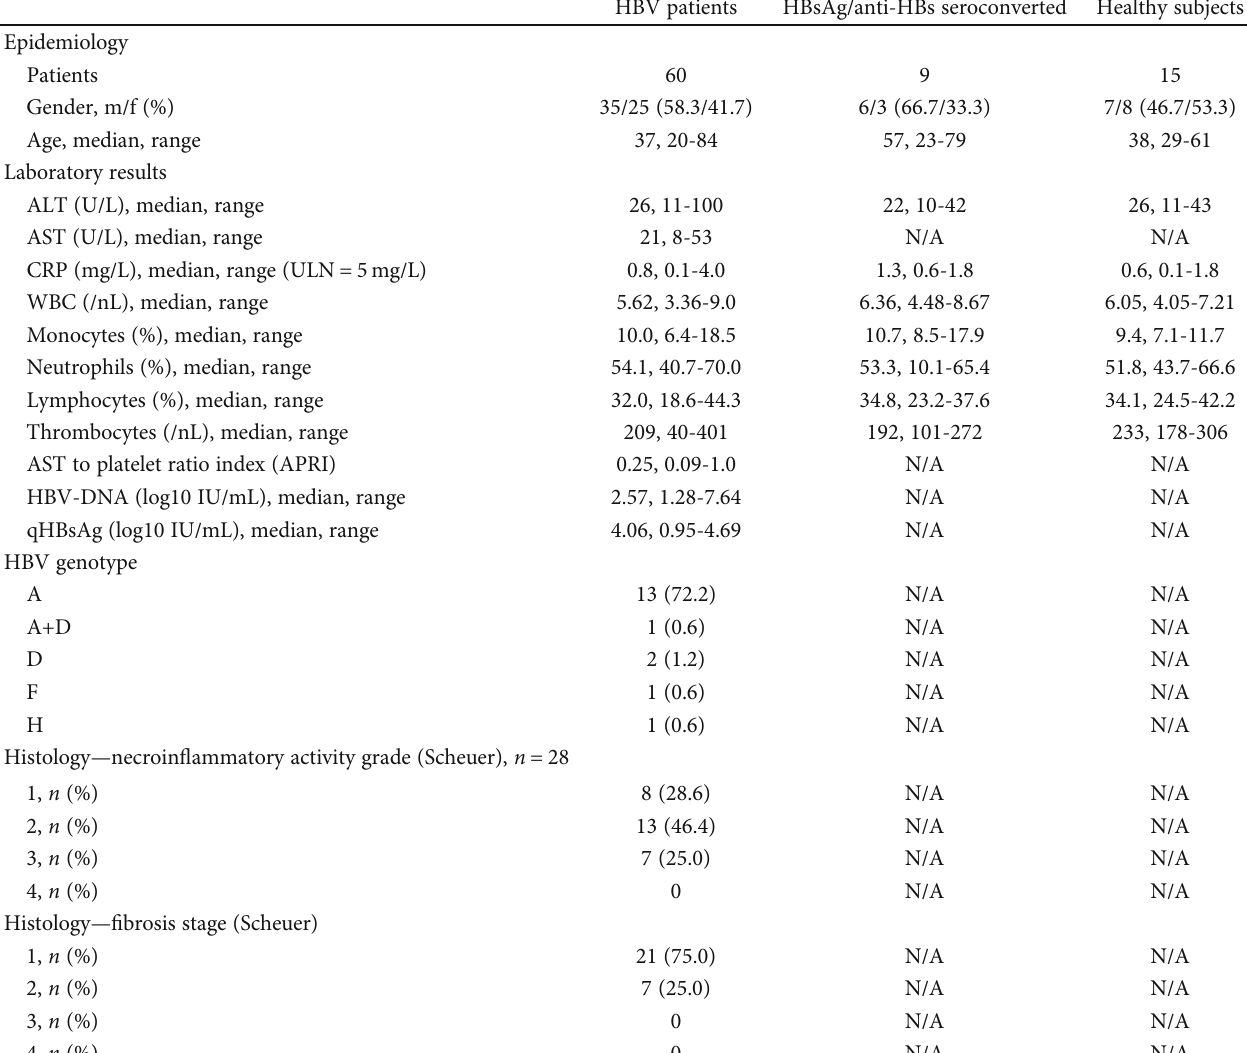
Table 1: Demographic, clinical, and laboratory characteristics of studied CHB groups. N/A: nonapplicable.